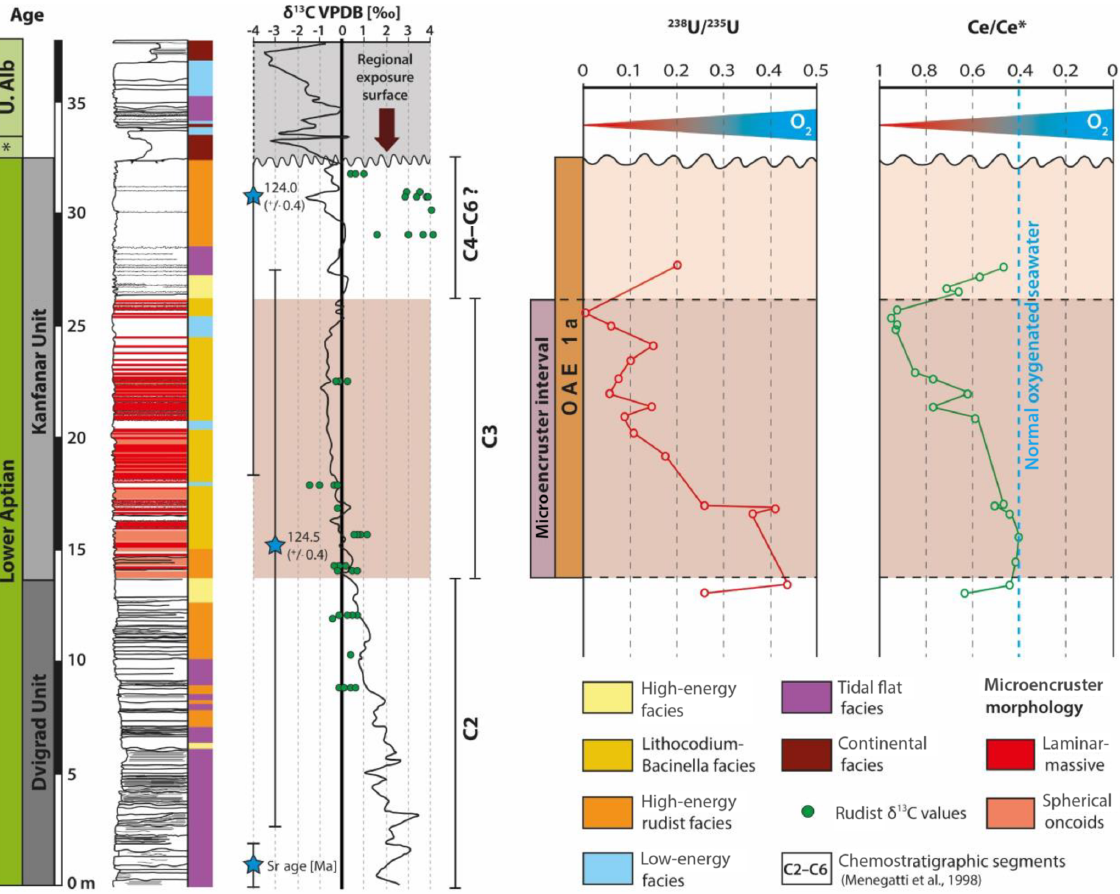
Figure 5. Chemostratigraphy of 238 U / 235 U and Ce / Ce ∗ ratios in the Kanfanar section. Note that the decreasing U and increasing Ce / Ce ∗ values are slightly offset during the C3 chemostratigraphic interval characterized by microencruster facies. Both redox proxies indicate a systematic decrease in dissolved seawater oxygen levels across chemostratigraphic segment